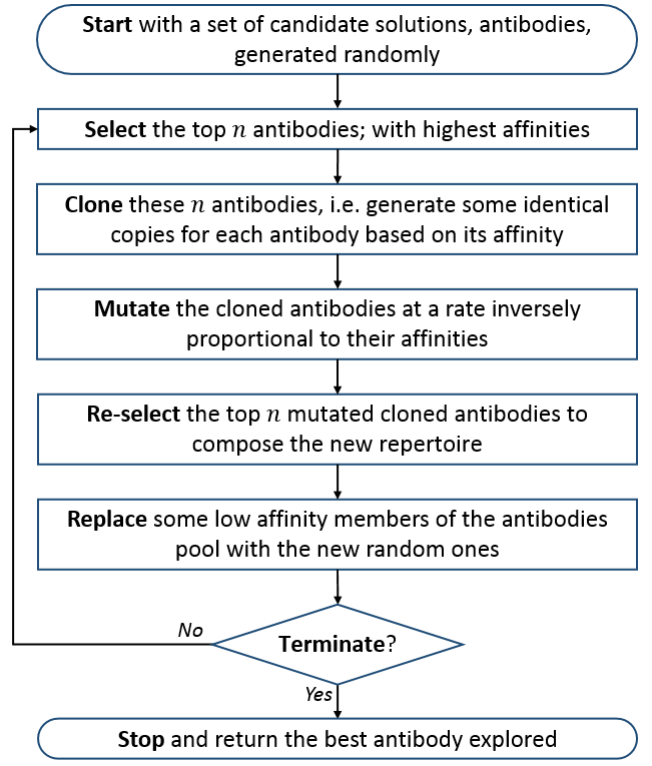
Figure 1. Flowchart of the CLONALG algorithm